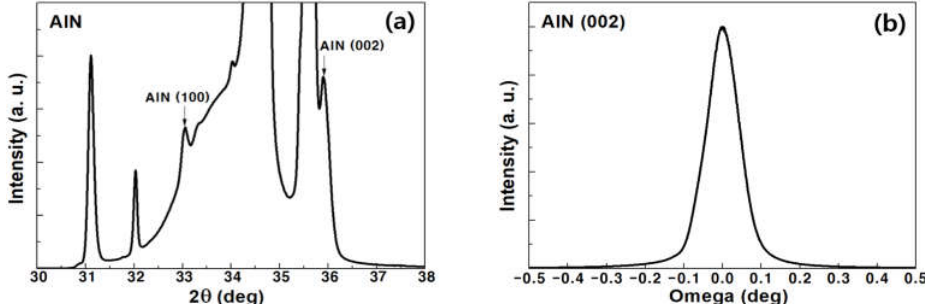
Figure 1. ( a ) XRD result and ( b ) rocking curve of AlN (002) plane of a 100 nm thick PEALD AlN film deposited on GaN surface.